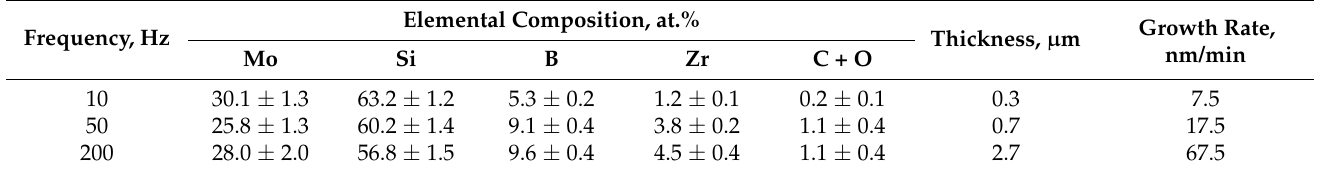
Table 2. The composition (according to the GDOES data), thickness, and growth rate of coatings.